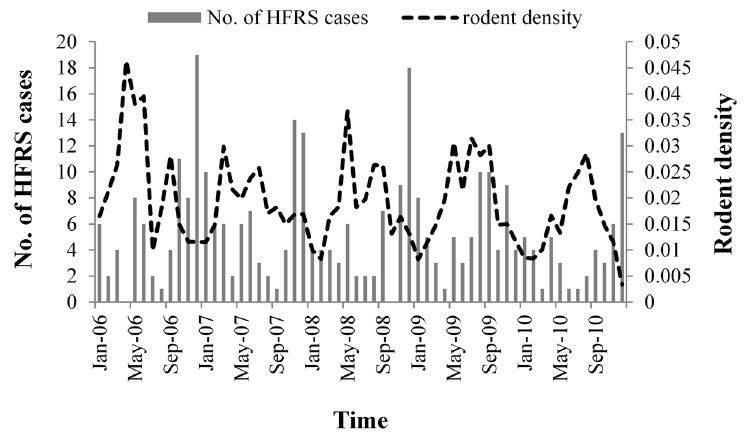
Figure 2. HFRS cases and rodent density.